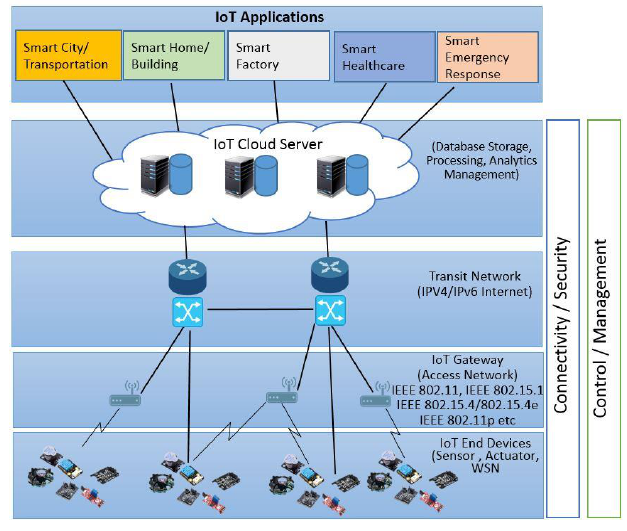
Figure 3. Conceptual view of the IoT.